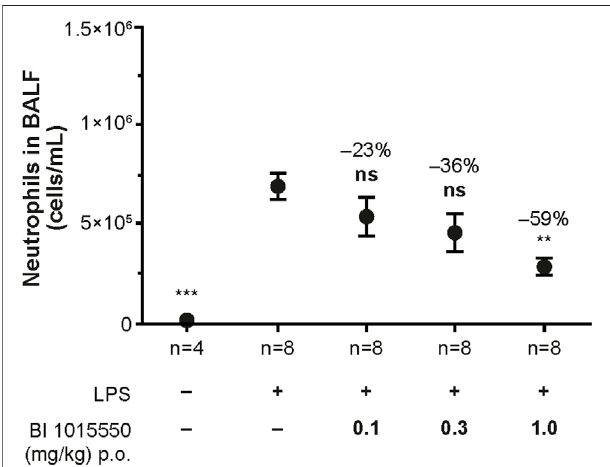
FIGURE 4 | Inhibition of LPS-induced neutrophil in fl ux into the BALF of SuncusmurinusbyBI1015550.Animalswerepre-treatedwithoralBI1015550 atthedoses indicated for 30 min beforeexposuretonebulizedLPSfor afurther 30 min. Thereafter, BALF was prepared and neutrophils were counted. Inhibition of neutrophils in % is given as negative number. Results are shown as means±SEMfromthenumberofanimalsindicated.**, p < 0.01;***, p < 0.001. BALF, bronchoalveolarlavage fl uid;LPS, lipopolysaccharide;ns, notsigni fi cant; p.o., orally; SEM, standard error of the mean.